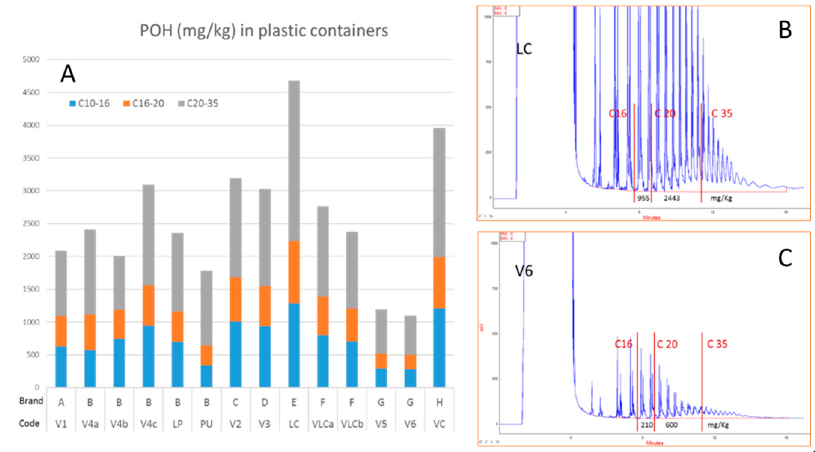
Figure 3. POH content (mg/kg) of the PP containers ( A ) and LC-GC-FID traces of two samples with high (V6 in subgraph ( B )) and low (LC in subgraph ( C )) residual POH.